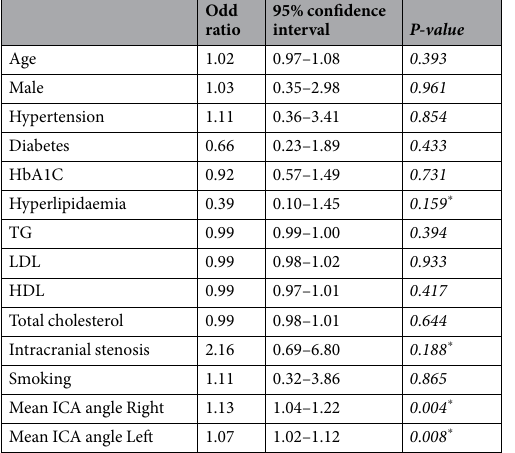
Table 2. Univariate logistic regression analysis for factors of risk of ischaemic stroke. * Variable which showed P < 0.2 in the univariate analysis were included in the multivariate analysis. LDL: low-density lipoprotein, HD: high-density lipoprotein, TG: triglycerides, ICA: internal carotid artery, HbA1C: glycated haemoglobin.